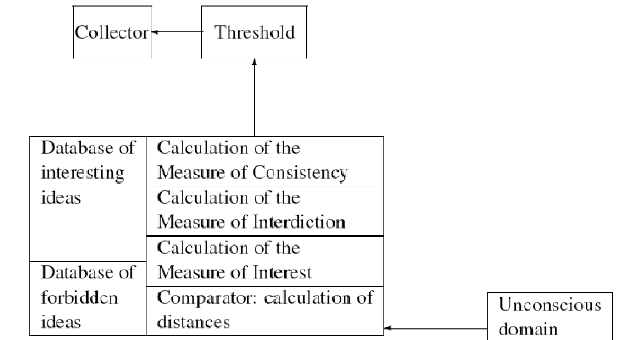
Figure 3. The structure of